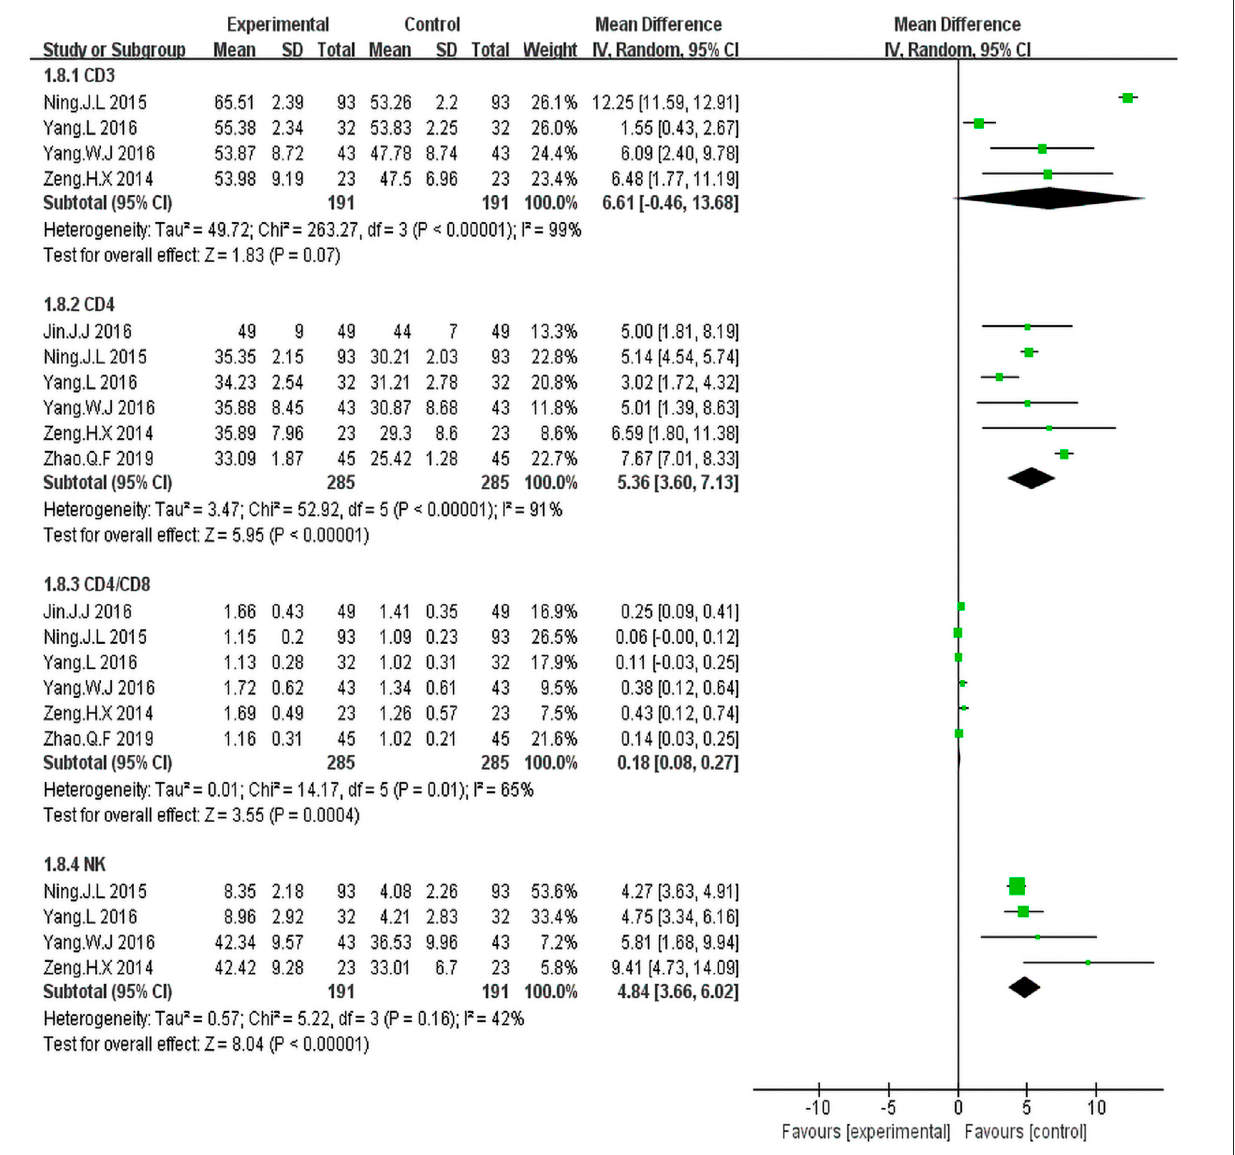
FIGURE 7 | Forest plot of Immune function in patients treated with KLT + EGFR-TKI and EGFR-TKI alone.